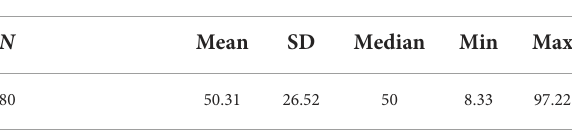
TABLE 6 EHFSc-9 Questionnaire results in the study group ( N = 80).